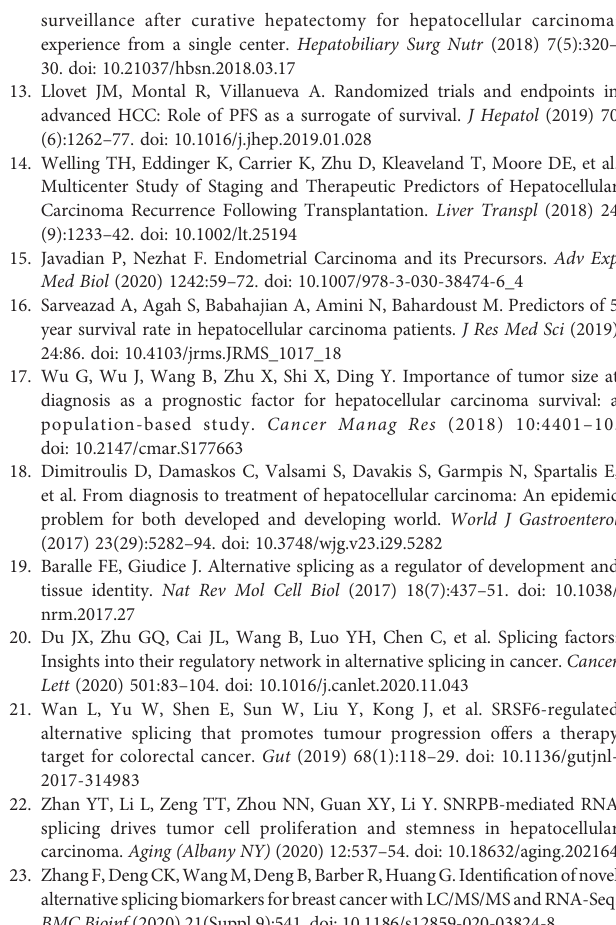
Supplementary Figure 1 | Knockdown ef fi ciency of HNRNPC in Huh-7 and Hep 3B cells, and KEGG analysis. (A) EGFP expression showing the infective ef fi